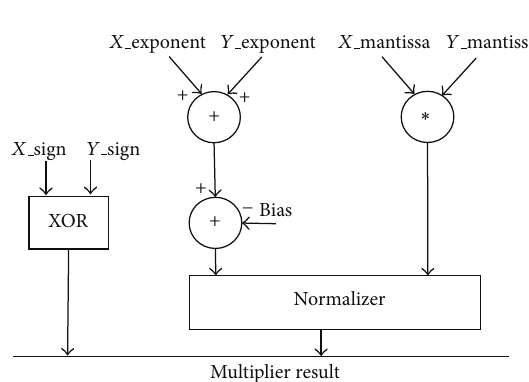
Figure 4: Existing synchronous floating point